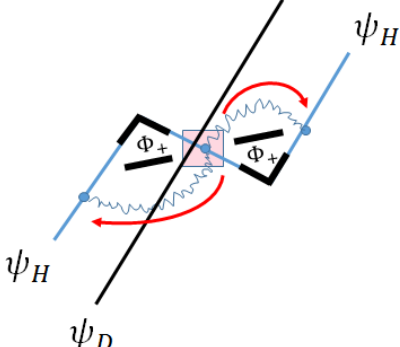
Figure 10 . Cloning through polyamorous